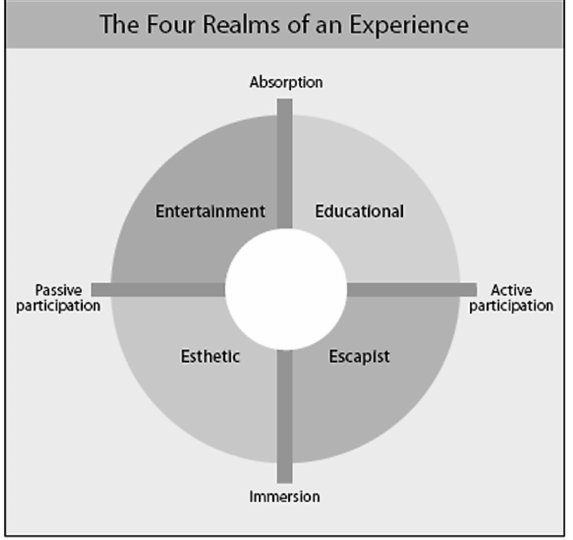
Figure 1. Four realms of the experience economy adopted from [16]. Reprinted with permission from ‘Welcome to the Experience Economy’ by B. Joseph Pine II; James H. Gilmore. Harvard Business Review, July 1998. Copyright 1998 by Harvard Business Publishing; all rights